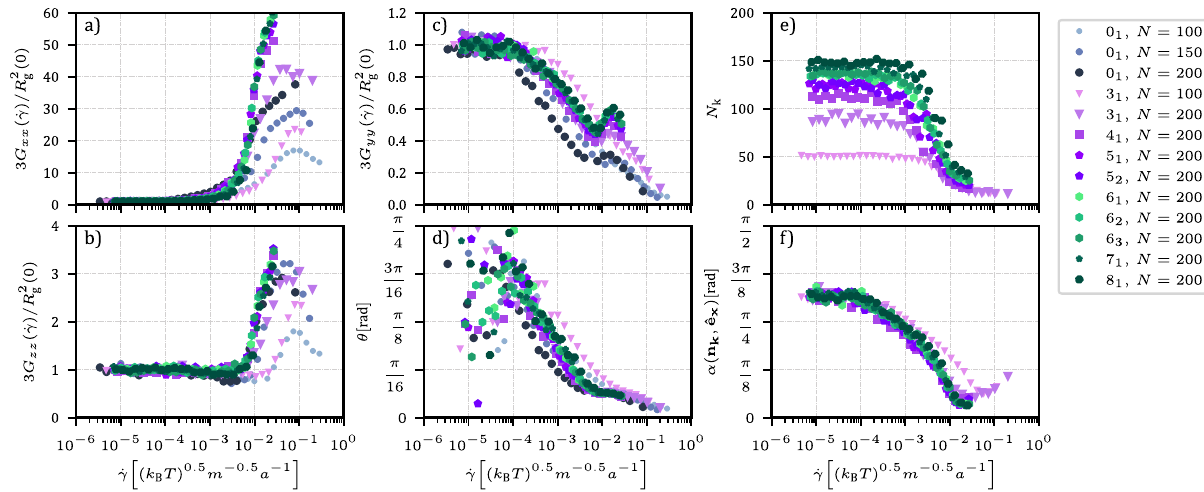
Fig. 5 Shape and orientation of knotted ring topologies under increasing shear rate. a G xx ( fl ow), b G zz (vorticity), c G yy (gradient), d alignment angle θ , e the number of beads on the knotted section, N k . f Angle α between vector n k from the ring's to the knotted section's centre of mass and axis vector ^ x , under strong shear, all knot topologies behave almost exactly like a ring with the same contour length N . Different colours correspond to different knot types, as indicated in the legend.